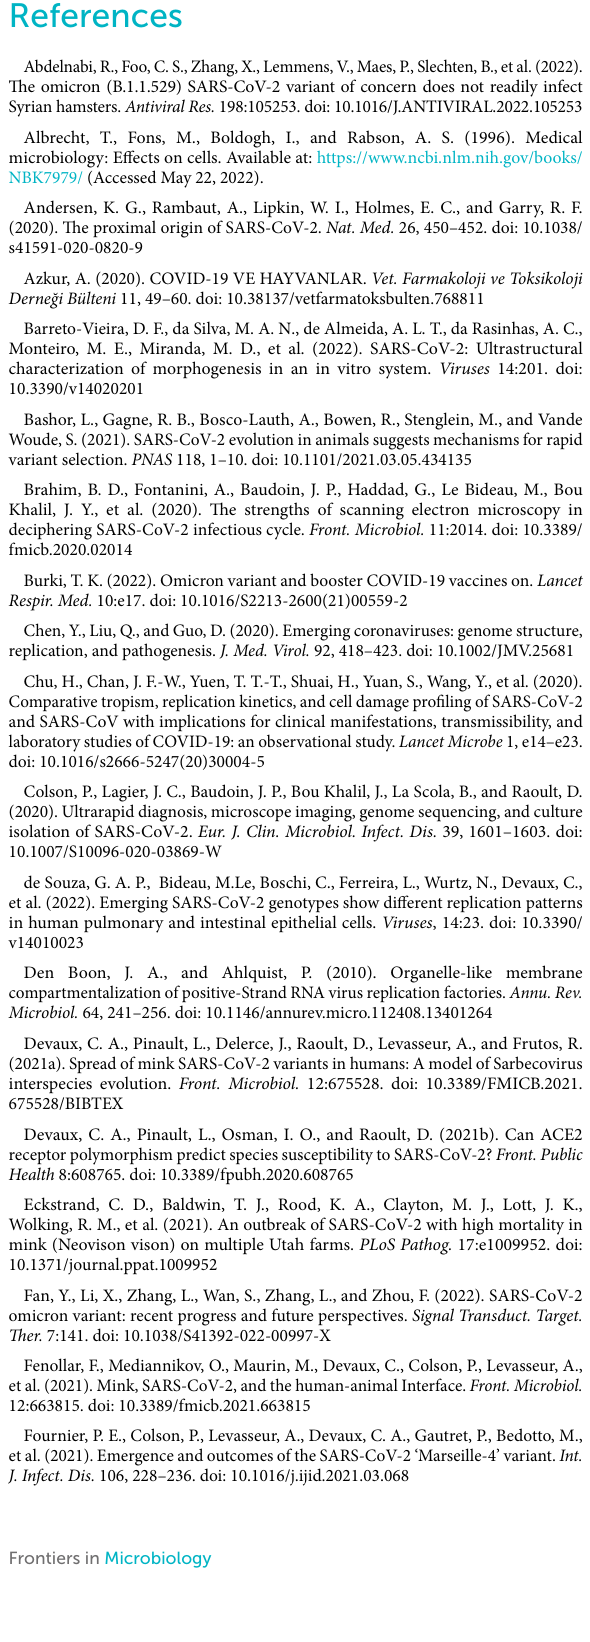
SUPPLEMENTARY FIGURE 1 Heatmap of replication rate among different SARS-CoV-2 isolates in mink lung cells 1-day post-infection. (A) Mv-1-Lu cells (B) ENL-R. SUPPLEMENTARY FIGURE 2 Absence of cytopathic effect on mink lung cells after 7 days post- infection with SARS-CoV-2 (IHU-MI 3